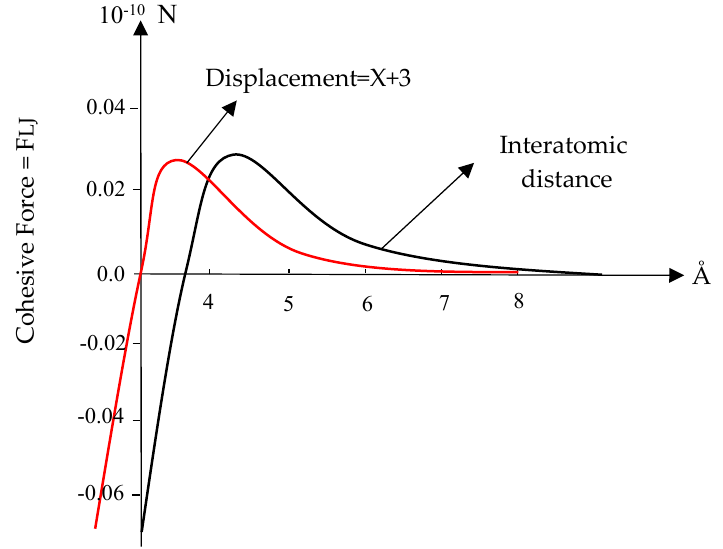
Figure 2. The van der Waals force versus interatomic distance and displacement curve.